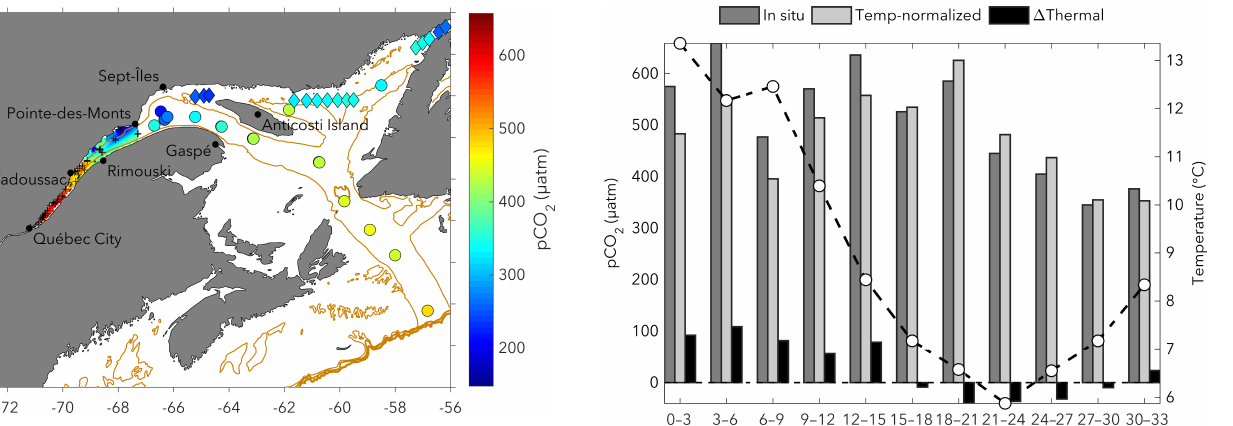
Figure 5. Spatial distribution of surface-water p CO 2 (µatm) in the EGSL during all spring and summer cruises. Linear interpo- lation was used between the sampling locations in the estuary ( + symbols). Circles show calculated p CO 2 (pH / TAlk), whereas di- amonds show p CO 2 measured by the underway system (General Oceanics model 8050) aboard the CCGS Amundsen in June 2016 (T. Papakyriakou, University of Manitoba, personal communica- tion, 2017). For neighboring locations sampled in May 2016 aboard the RV Coriolis II , measured and calculated p CO 2 differed by, on average, ∼ 4.2 %. The mean atmospheric p CO 2 during the sam- pling months ranged from 372 to 405µatm.